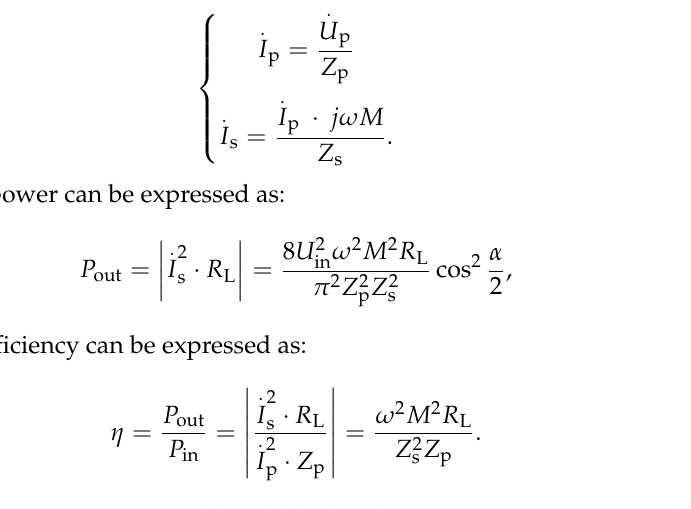
Table 1. Experimental parameters.